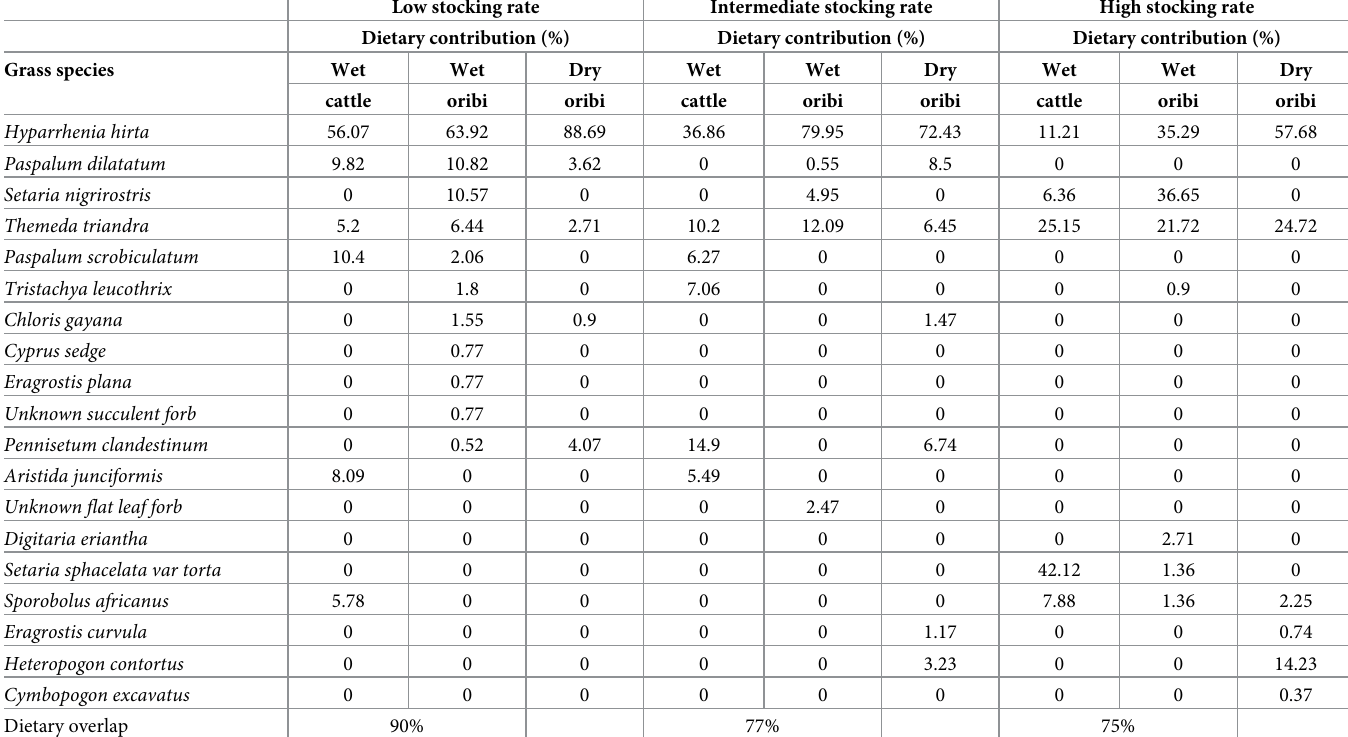
Table 1. Dietary contribution of consumed grass species for cattle (wet season only) and oribi ( Ourebia ourebi ) antelope (wet and dry season) at low (1.7 ha/AU), intermediate (1.5 ha/AU), and high cattle stocking rates (0.95 ha/AU). Spatial and temporal overlap between the two herbivores only occurred during the wet season so the dietary overlap reflects the overlap between the top contributing grass species in the wet season diet of cattle and